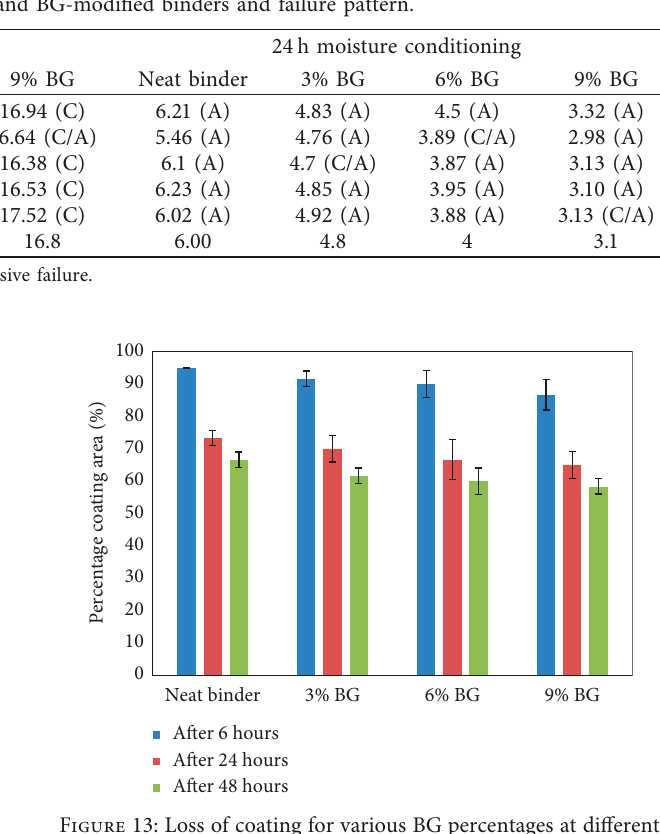
nr values of the asphalt binder at 70